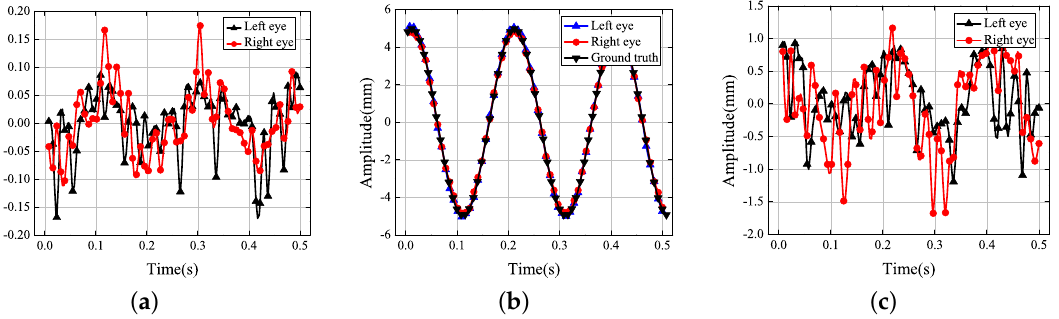
Figure 4. Experimental results for the amplitude in each translational direction: ( a ) X axis; ( b ) Y axis; ( c ) Z